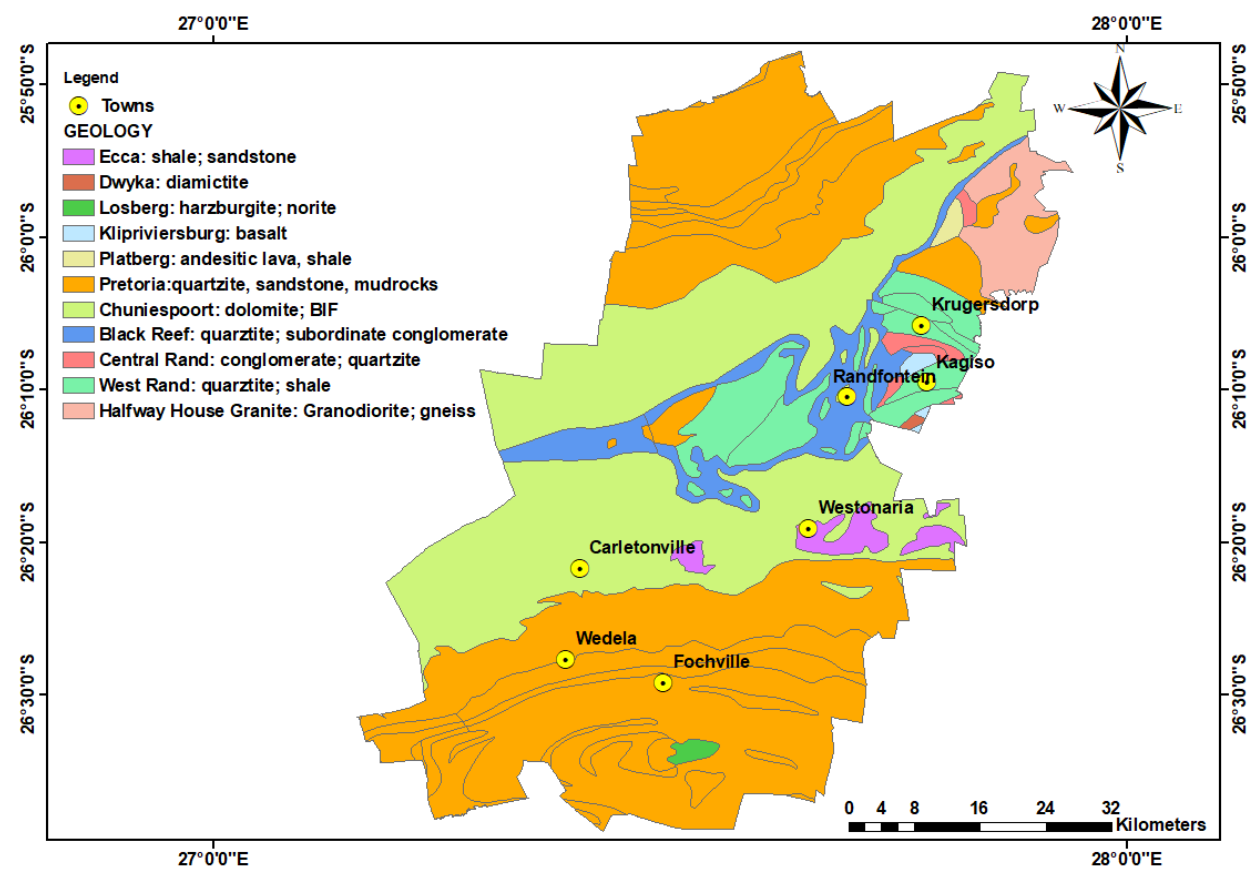
Figure 2. Geological map of the study area.